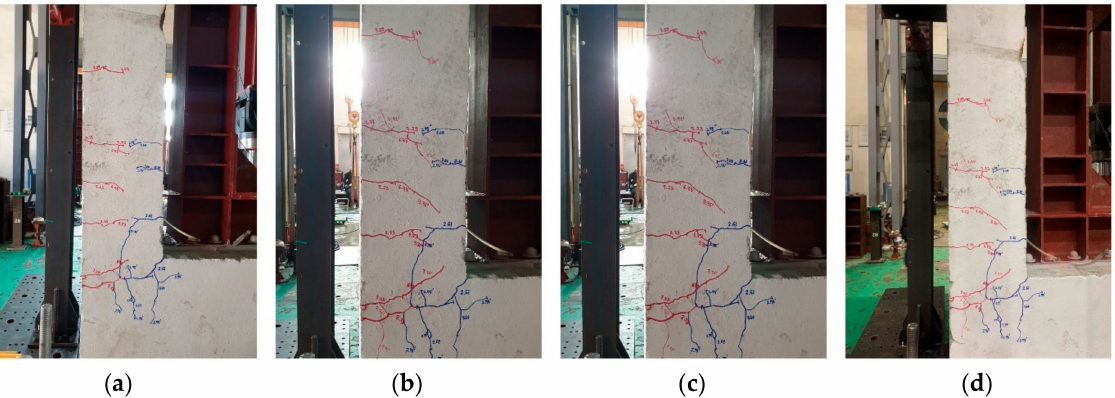
Figure 17. Cracks and ultimate state of test frame retrofitted with NBSD-WSCS (PD-NBSD-WSCS) (300 cm/s 2 ): ( a ) flexural and shear cracks at around 2.75 s (37 mm), ( b ) flexural and shear cracks at around 3.31 s (46.6 mm), ( c ) flexural and shear cracks at around 3.7 s (49 mm), and ( d ) patterns at the final stage (10 s).